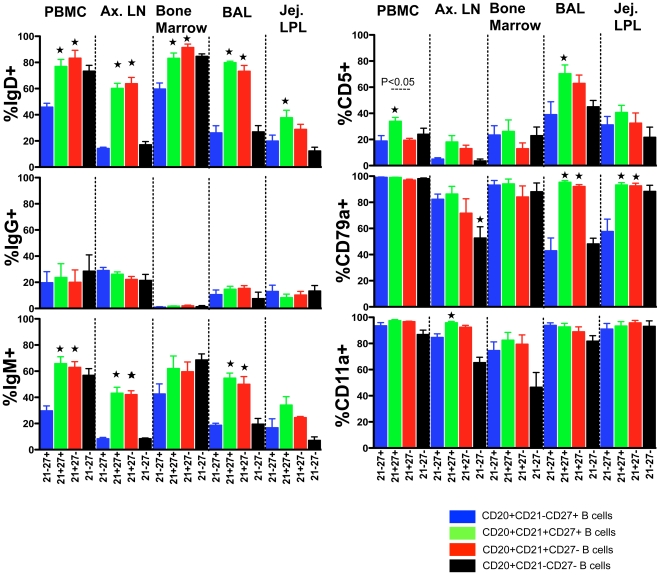
Relative expression of immunoglobulin receptors (IgD, IgG and IgM), other receptors (CD5, CD79a, and CD11a) in different subpopulations of CD20+ B cell in both peripheral and lymphoid tissues from normal healthy macaques (mean ± standard error).Cells were gated first on singlets, and then on CD20+ B lymphocytes. All CD20+ B cells were further analyzed based on their CD21 and CD27 surface molecule expression. Statistically significant differences between DP CD21+CD27+ and SP CD21+ B cell subsets are shown.  Indicates significant differences between SP CD27+ B cells and other B cell subsets for the specified tissue.